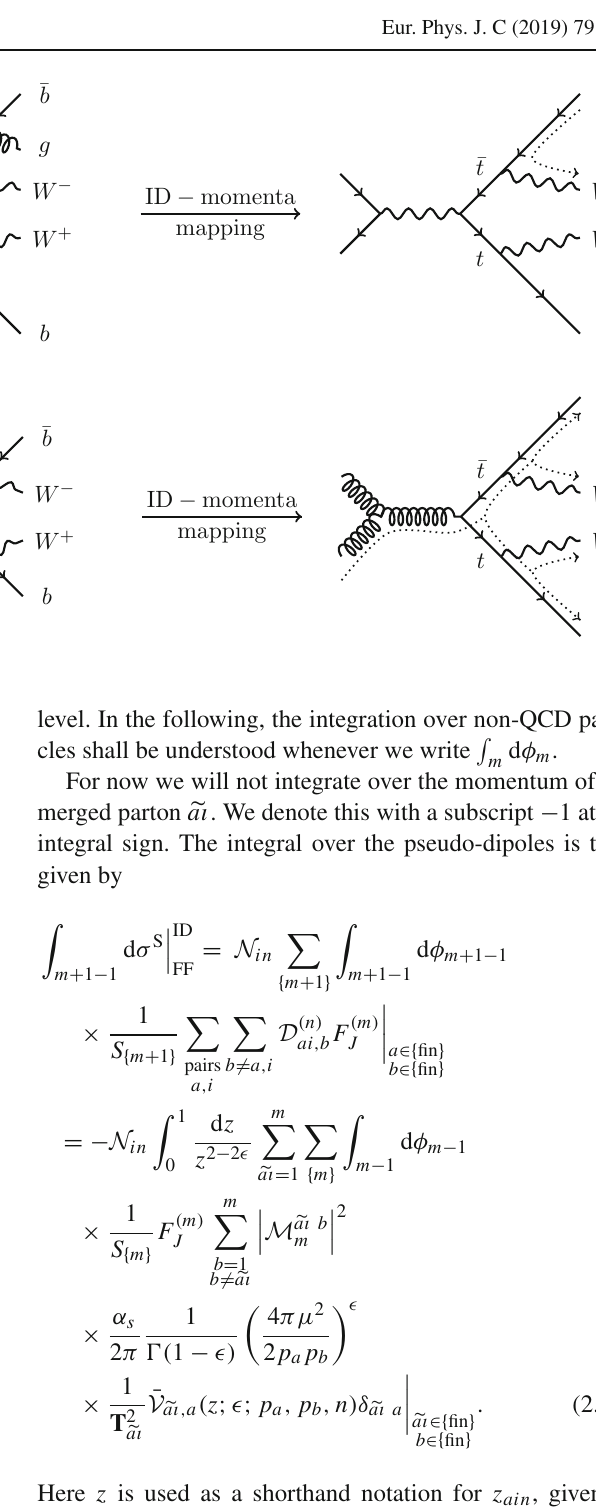
Fig. 5 Possible real correction configuration for W + W − b ¯ b production and Born configuration of associated pseudo-dipoles. The curved arrow on the right indicates the flow of the recoil